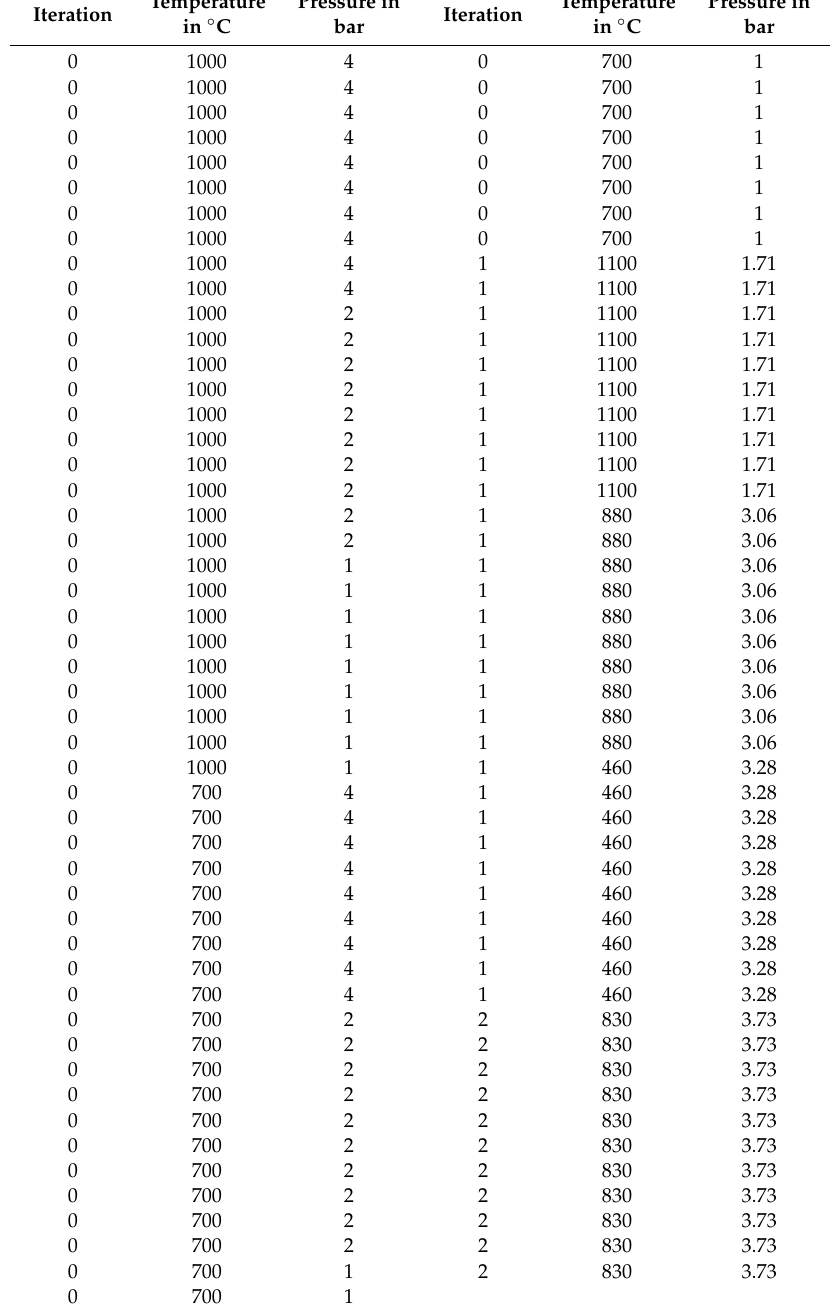
Table A1. Input and output parameters for all